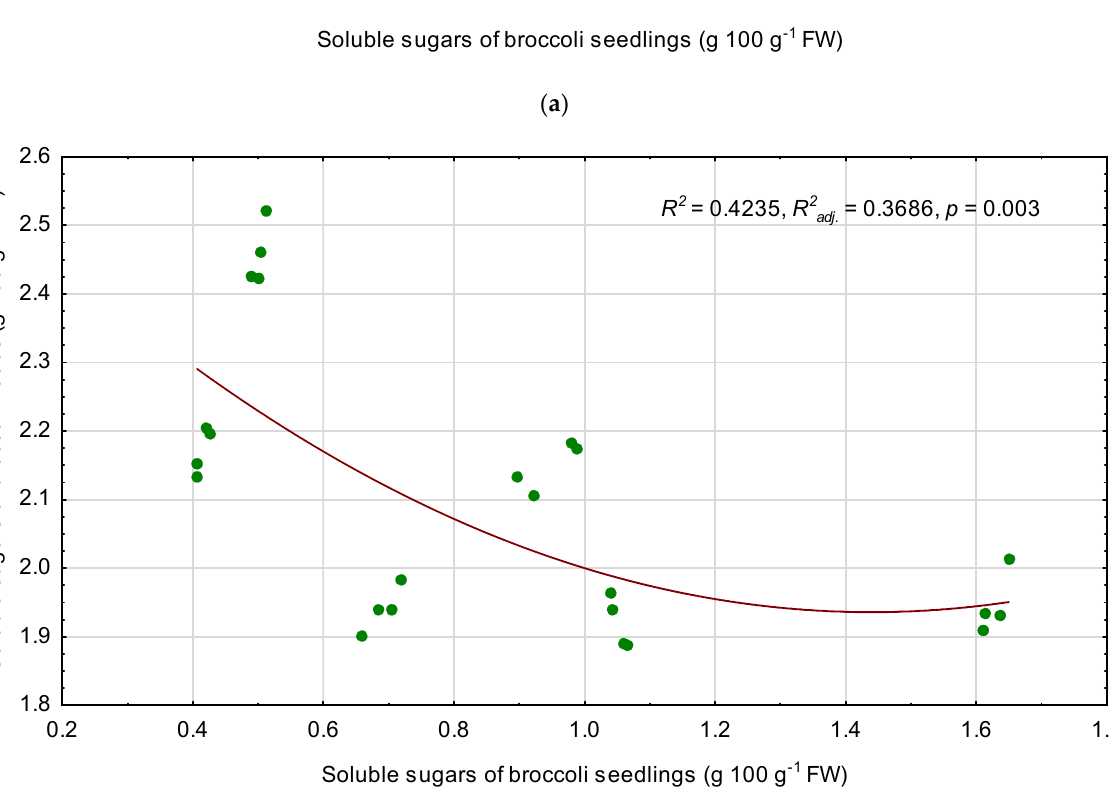
Figure 3. Linear relationship between soluble sugars (SS) of broccoli seedlings and SS content of fully mature broccoli heads, separately for temperature duration ( a ), and polynomial regression model for SS content of broccoli heads depending on the SS content of the seedlings ( b ). r —Pearson correlation coefficient, R 2 —coefficient of determination, R 2 adj —adjusted coefficient of determination, p —probability level.